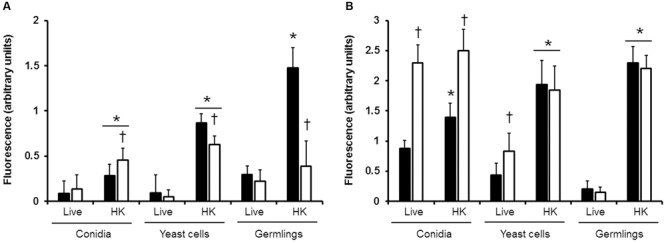
Exposure of chitin and β1,3-glucan at the cell wall surface of different morphologies of S. schenckii sensu stricto and S. brasiliensis. Live or heat-killed cells (HK) from S. schenckii sensu stricto (closed bars) or S. brasiliensis (open bars) were incubated with either WGA-FITC (A) or IgG Fc-Dectin-1and then with FITC-conjugated IgG (B) to label chitin or β1,3-glucan, respectively. Three hundred cells were analyzed for each group. ∗P < 0.05, when compared with the live cells; †P < 0.05 when compared to S. schenckii sensu stricto cells under the same morphology and condition.